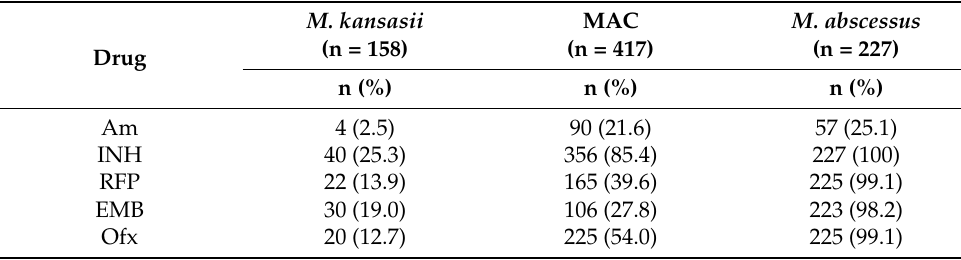
Table 1. Drug resistance rates of the three major NTM species.